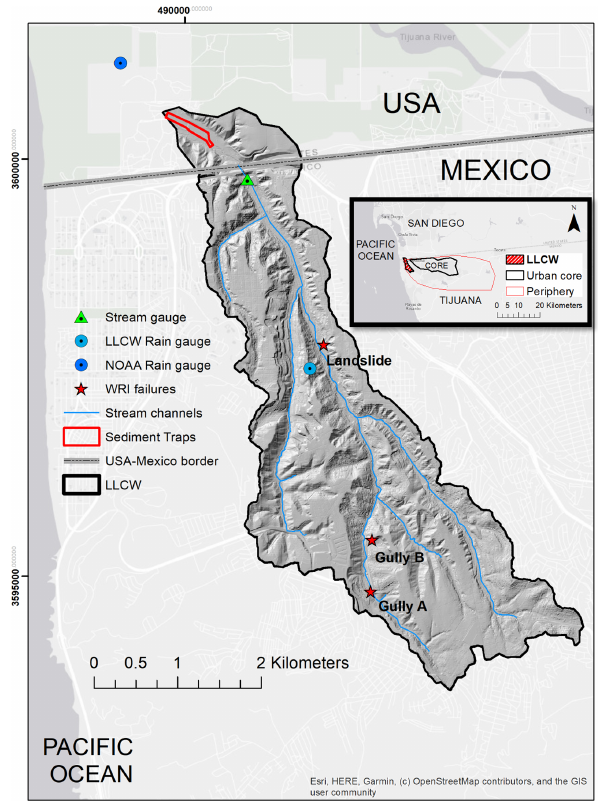
Figure 1. The Los Laureles Canyon watershed (LLCW), locations of water resources infrastructure failures (WRIFs), and field equip- ment. Inset shows the regional location of the LLCW within the urban periphery. Base map ©OpenStreetMap contributors 2020. Distributed under the Open Data Commons Open Database Li- cense (ODbL)